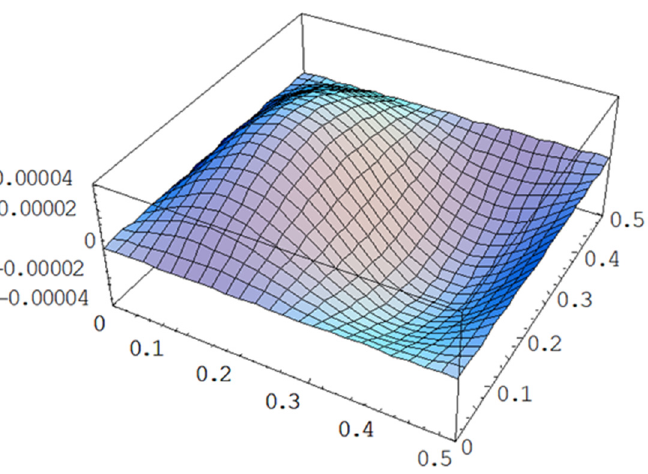
Figure 11. Mode (2,1) shape of the simply supported composite laminate plate.